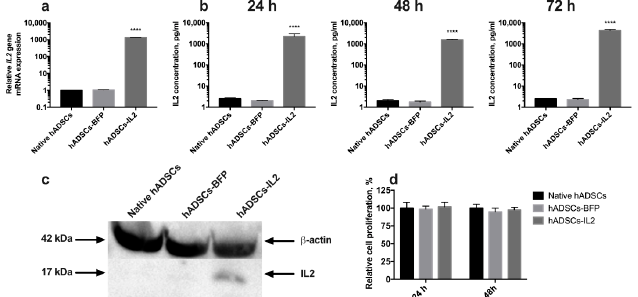
Figure 1. Detection of interleukin 2 (IL2) expression in human adipose tissue-derived mesenchymal stem cells (hADSCs). ( a ) Relative expression of the IL2 gene mRNA in hADSCs-IL2 was 1000-fold increased. The data were normalized using an 18S ribosomal RNA housekeeping gene. Bars represent the mean of two biological replicates with their corresponding standard deviation (SD) ( n = 6). ( b ) The secretion of IL2 protein was increased 2000-fold in hASDCs-IL2 compared to native hADSCs and hADSCs-blue fluorescent protein (BFP) after 24 h of cultivation. This significant increase in IL2 secretion by hADSCs-IL2 was maintained when analyzed in media conditioned for 48 and 72 h. ( c ) Expression of IL2 protein was confirmed using Western blot analysis with β -actin serving as an internal control. ( d ) Relative proliferation of hADSCs at 24- and 48-h post seeding in vitro has no statistically significant difference between cell cultures. Each value is presented as the % in relation to the control (native hADSCs) group. Bars represent the mean ± SD ( n = 6) of two biological replicates. **** p < 0.0001.